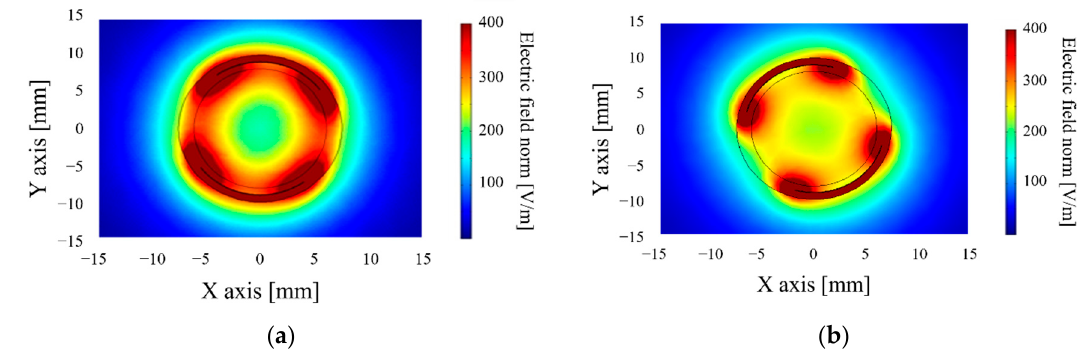
Figure 12. Electric field density around the first design ( a ) helicoidal sensors and the optimized design ( b ).